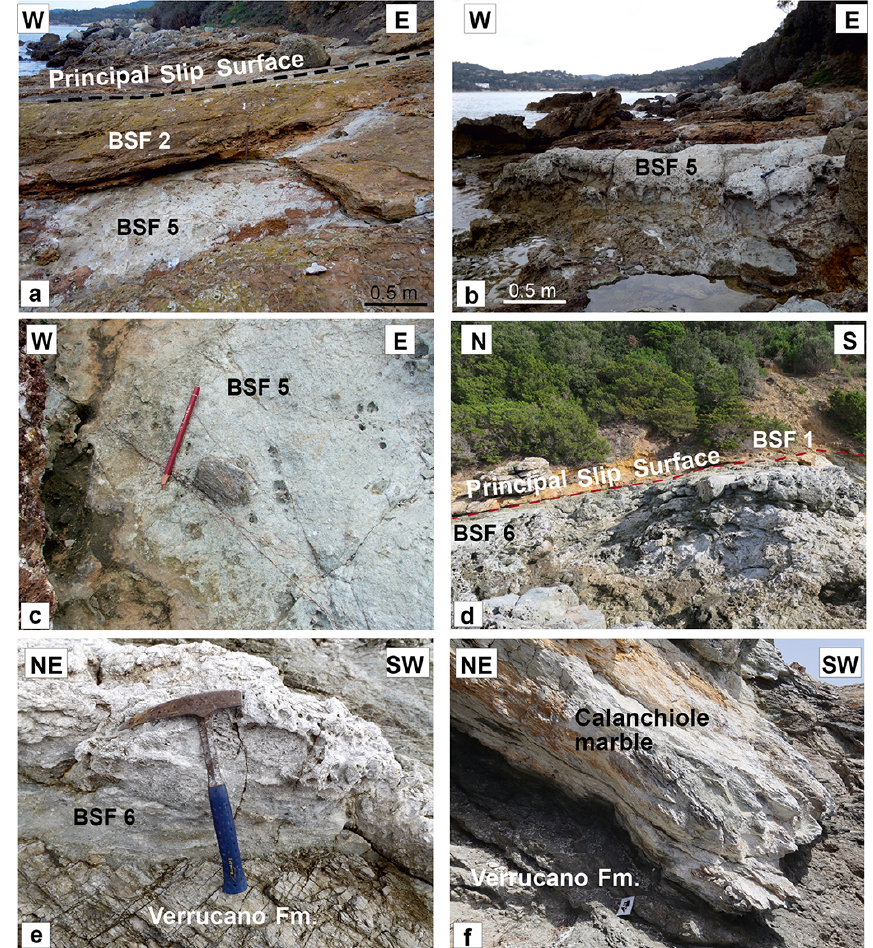
Figure 6. (a) BSF 5 upper contact to the foliated cataclasite of BSF 2. The latter is truncated by the ZF principal slip surface. (b) The distinctive look of the lower massive greyish to whitish cataclasite exhibits a honeycomb texture as result of clast erosion. (c) Detail view of centimetre-sized clasts, varying from subrounded quartz to angular hornfels slate embedded in a massive fine- to medium-grained matrix. (d) BSF 6 in the immediate footwall of the ZF PSS along the N–S section at Punta Zuccale. The image is ca. 5m in width. (e) Outcrop view of decimetric layers of the BSF 6 whitish to greyish lower breccia resting above the Triassic quartzite of the Verrucano Fm. (f) W-dipping foliated marble of the Calanchiole shear zone in the footwall of the